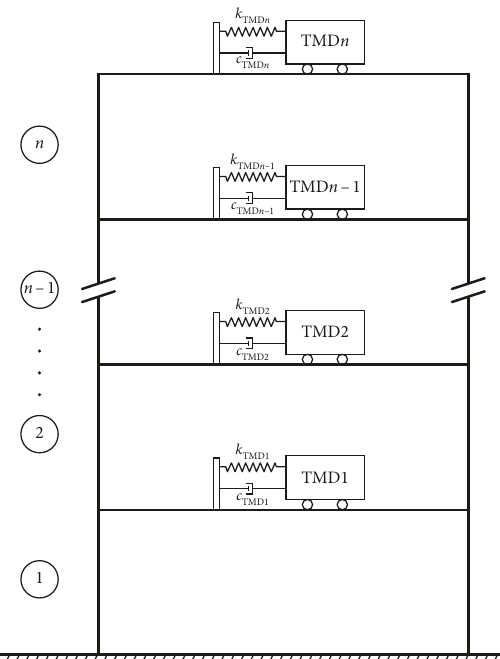
Figure 1: n -degree-of-freedom building with N tuned mass dampers vertically distributed along the building (adapted from Fadel Miguel et al.